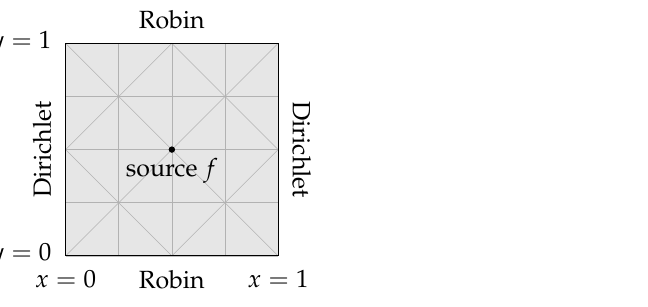
Figure 2. Schematic of the 2D wave guide model problem with example triangular